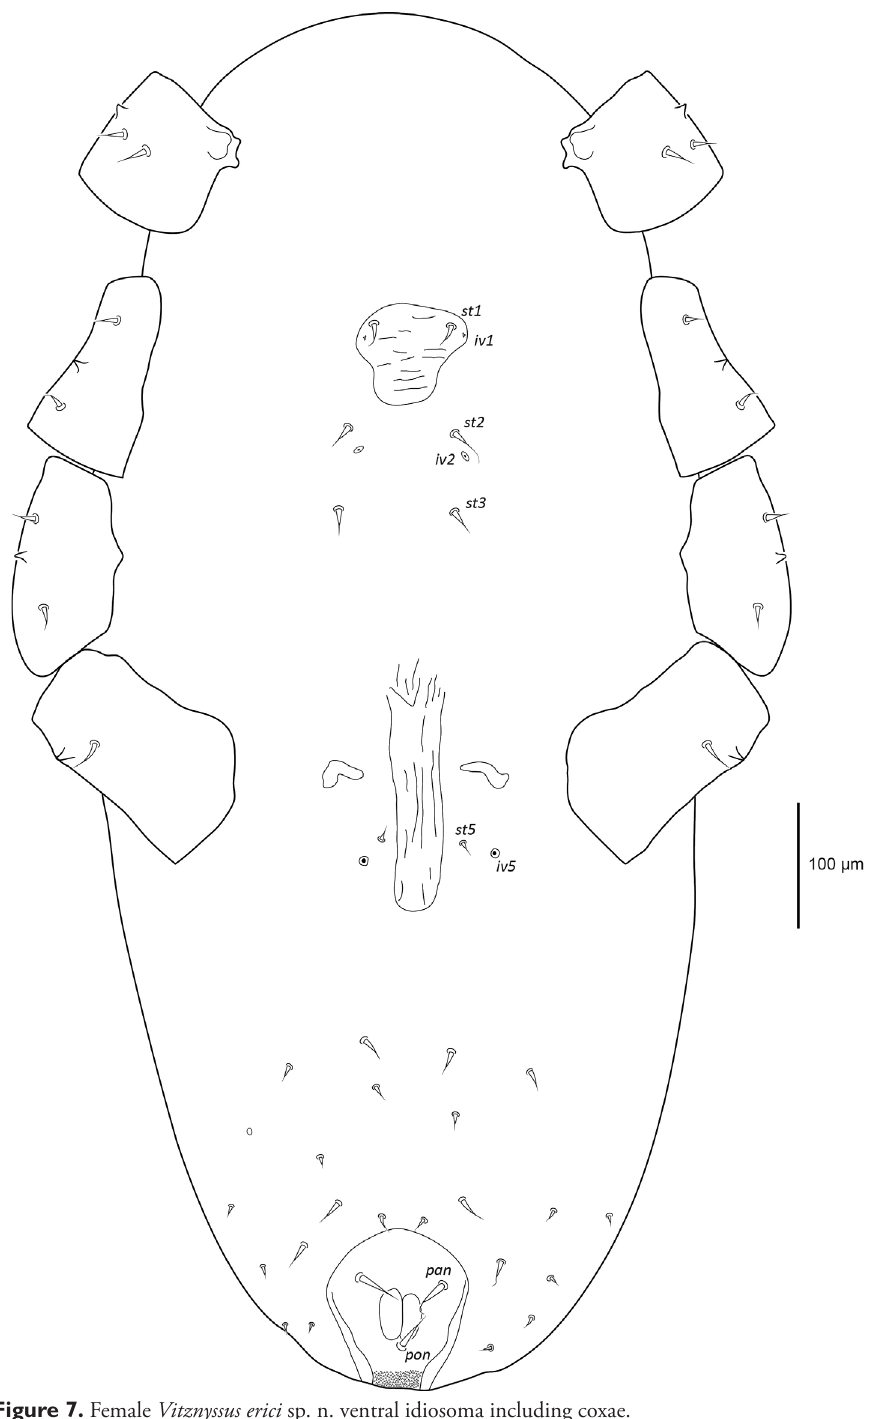
Figure 7. Female Vitznyssus erici sp. n. ventral idiosoma including